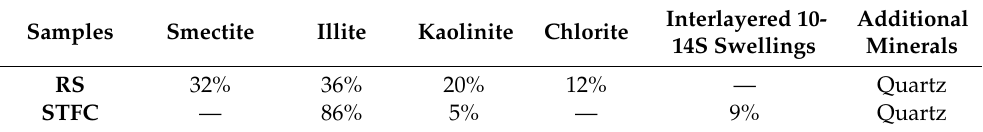
Table 5. Identification of clay minerals by the XRD